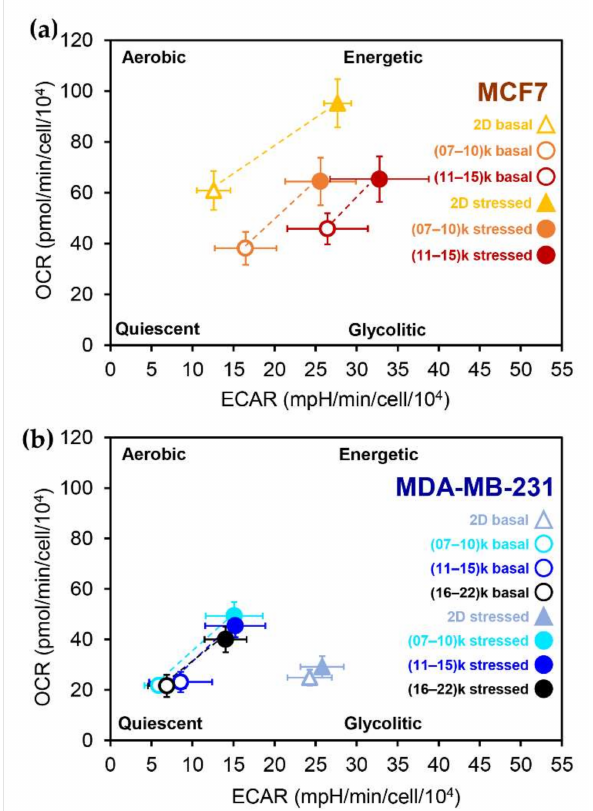
Figure 6. Comparisons of bioenergetic characterization by Seahorse analysis between the 2D and 3D cultures of the MCF7 cell line ( a ) and MDA-MB-231 cell line ( b ), possible due to cell number normalization using imaging techniques, i.e., nuclei counting using Hoechst dye in 2D cultures, area measurement for 3D cultures. Both cell lines were analyzed in three different conditions: growth in monolayer (MCF7 n = 37; MDA-MB-231 n = 41), spheroids produced with the Single Spheroid Protocol , and seeding different numbers of cells per well (5000–10,000–15,000). Spheroids have